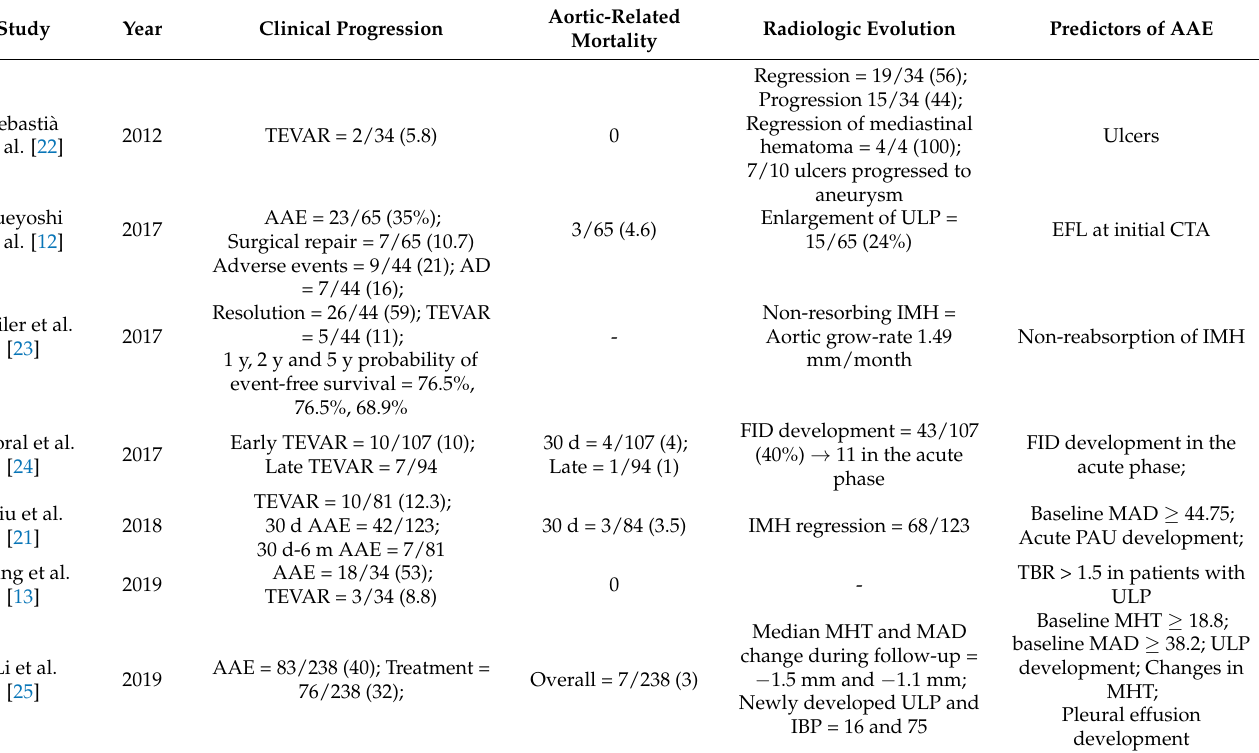
Table 4. Focus on studies reporting on intramural hematoma (IMH). MAD: maximum aortic